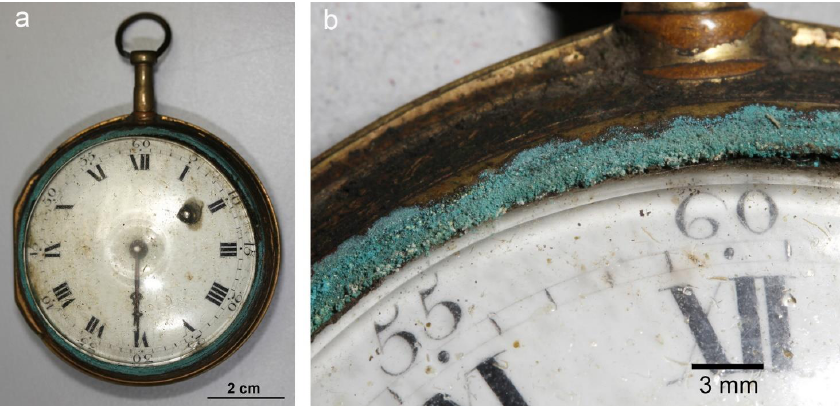
Figure 8. ( a ) Pocket watch of the Museum für Hamburgische Geschichte, Inv. Nr. 1899.101b, ( b ) green ⑤ and white ⑦ corrosion.